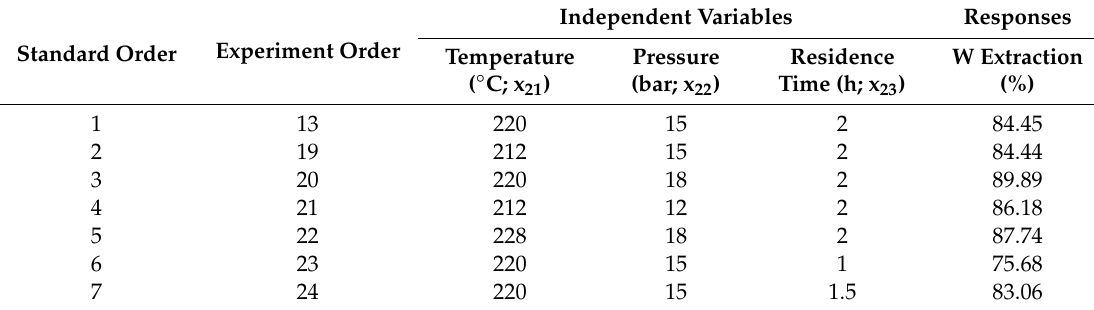
Table 6. Experiment conditions and responses of pressure-leaching